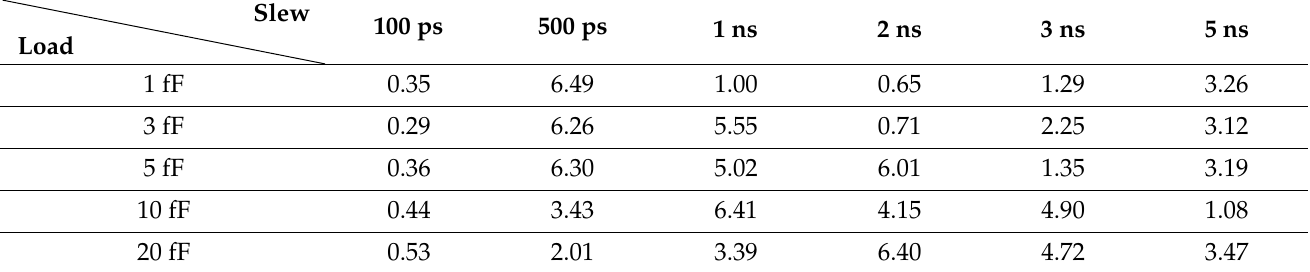
Table 3. Standard deviation error with the proposed model for NOR (%).